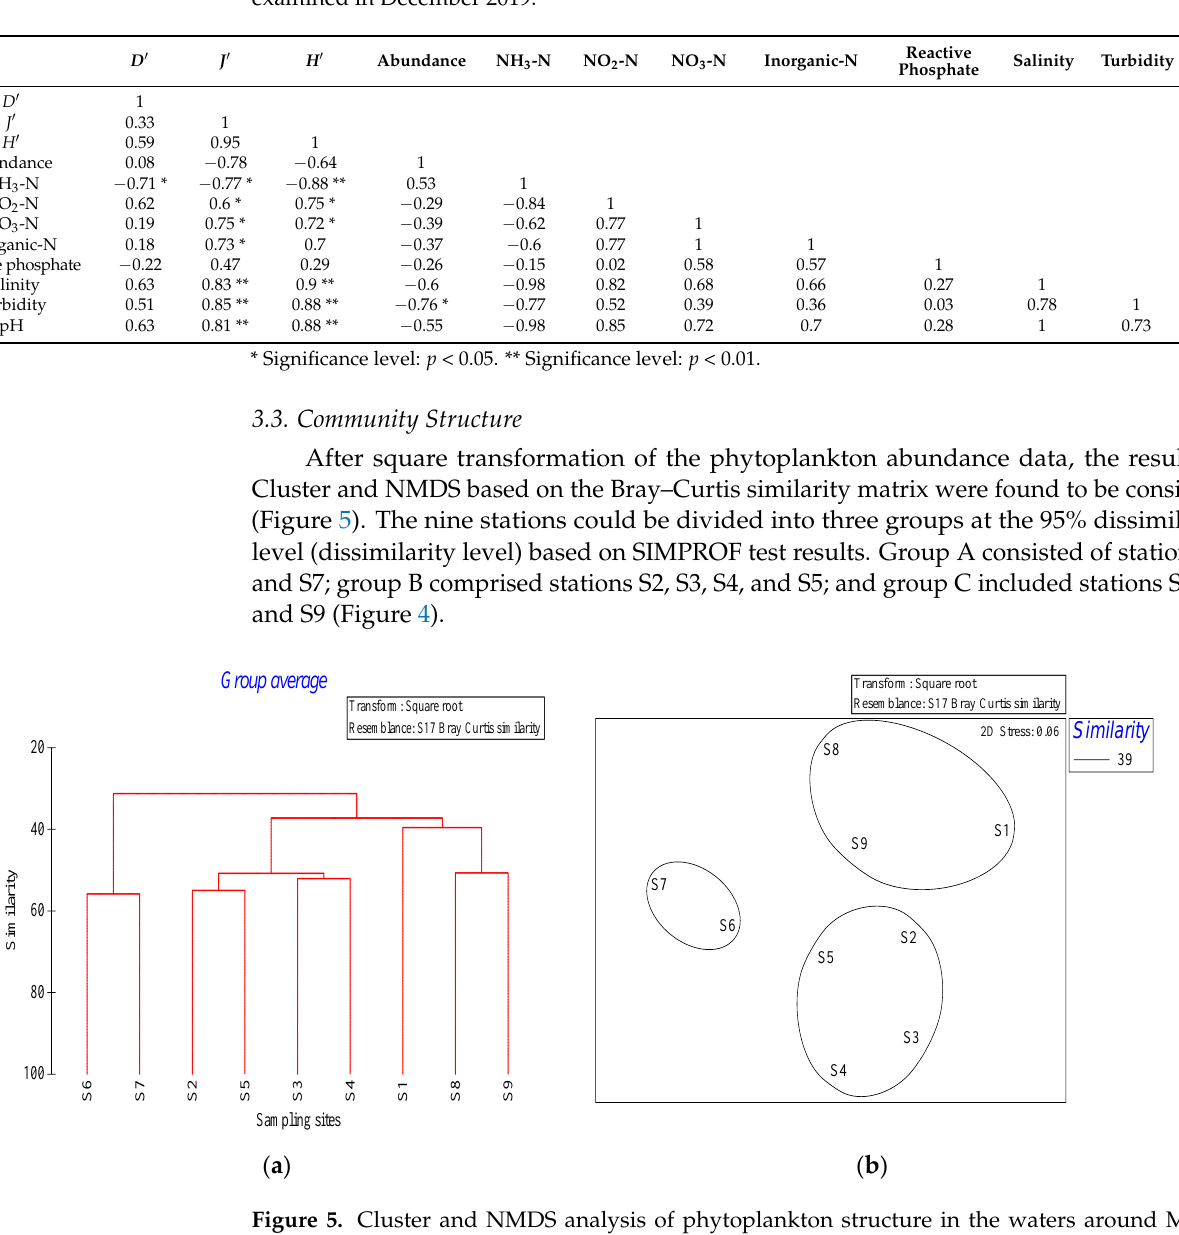
Table 4. Correlation coefficient of richness index ( D’ ), Pielou evenness index ( J’ ), Shannon – Wiener index ( H ′ ), depth, abundance, ammonia nitrogen, nitrite nitrogen, nitrate nitrogen, inorganic nitro- gen, reactive phosphate, salinity, turbidity, and pH of phytoplankton in the waters around Macau examined in December 2019.